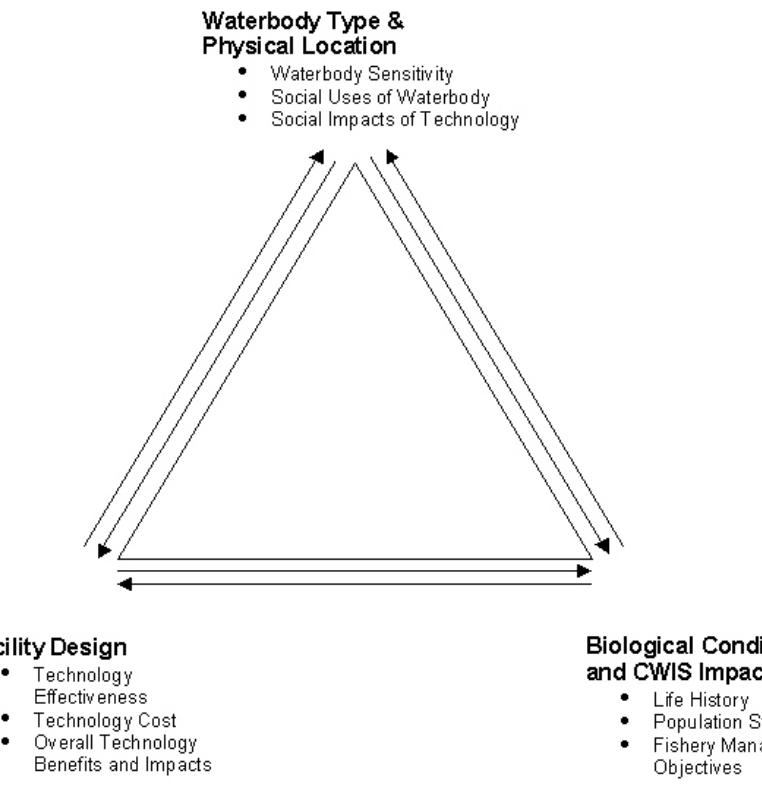
FIGURE 1. Key components for effective 316(b)